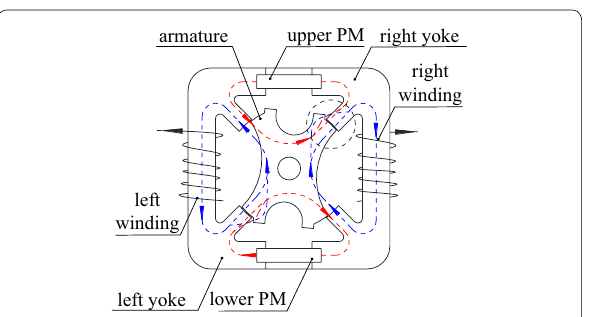
θ α 2 R 1 R 2 Figure 6 Schematic of axial air gap